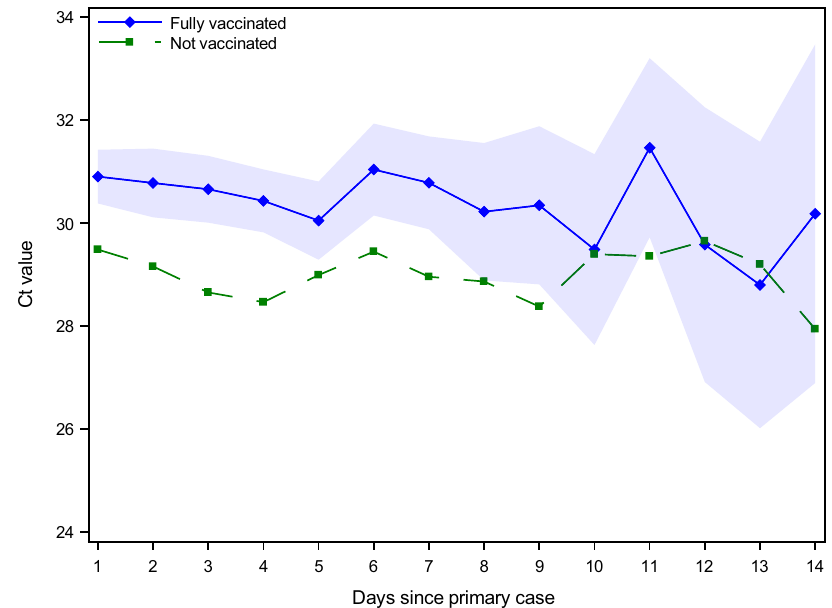
Fig. 2 Ct values across vaccinated and unvaccinated positive secondary cases. The Ct values in samples for positive secondary cases of unvaccinated and fully vaccinated follow the same pattern, indicating that the higher Ct values for fully vaccinated individuals is consistent and unrelated to the time of testing positive. Markers present point estimates, while shaded areas are 95%-con fi dence intervals clustered on the household level. Regression estimates include age fi xed effects. Table S4 provides regression estimates of the increased Ct values for vaccinated secondary